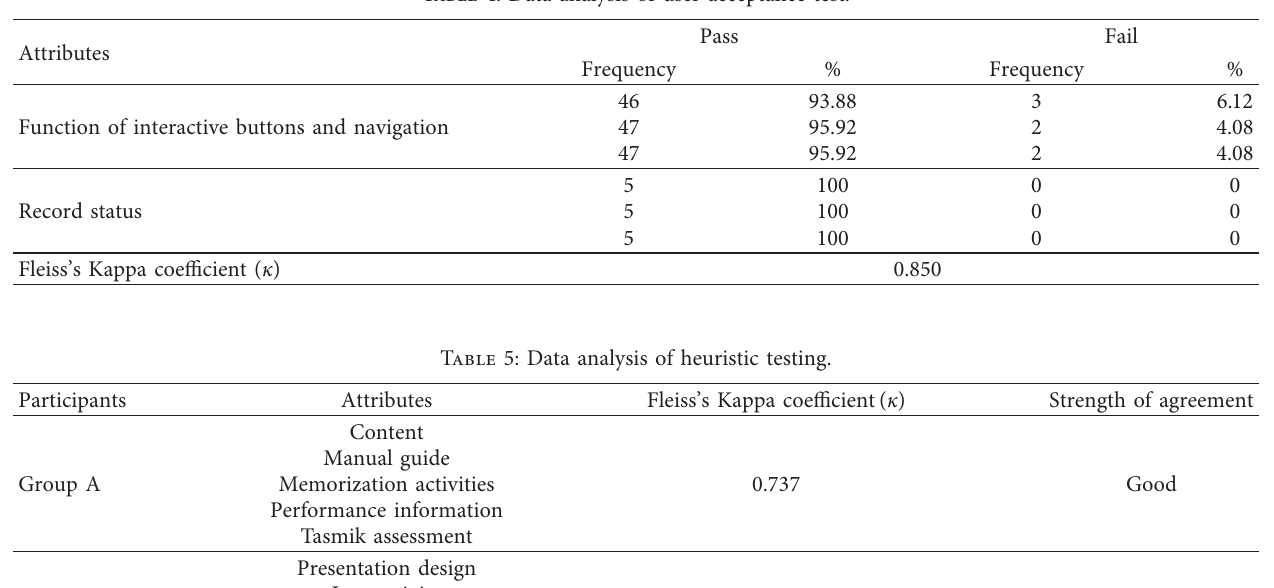
Table 4: Data analysis of user acceptance test.